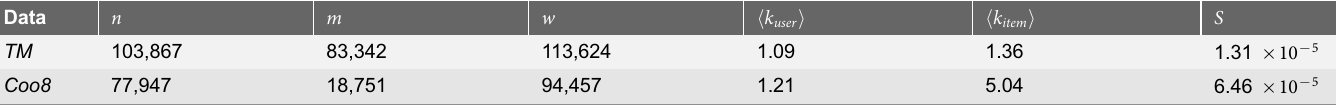
n , m , and w represent the number of users, items and links, h k user i and h k item i stand for the average degrees of users and items, and S ~ w